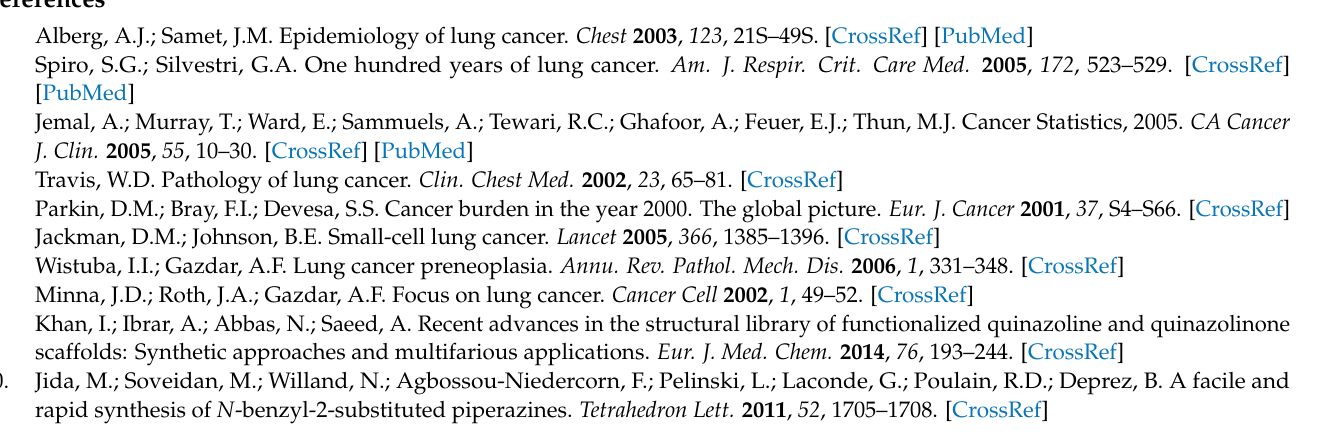
Figure S2: 13 C NMR spectrum of 5a , Figure S3: 1 H NMR spectrum of 5b , Figure S4: 13 C NMR spectrum of 5b , Figure S5: 1 H NMR spectrum of 5c , Figure S6: 13 C NMR spectrum of 5c , Figure S7: 1 H NMR spectrum of 5d , Figure S8: 13 C NMR spectrum of 5d , Figure S9: 1 H NMR spectrum of 5e , Figure S10: 13 C NMR spectrum of 5e , Figure S11: 1 H NMR spectrum of 5f , Figure S12: 13 C NMR spectrum of 5f , Figure S13: 1 H NMR spectrum of 5g , Figure S14: 13 C NMR spectrum of 5g , Figure S15: 1 H NMR spectrum of 5h , Figure S16: 13 C NMR spectrum of 5h , Figure S17: 1 H NMR spectrum of 5i , Figure S18: 13 C NMR spectrum of 5i , Figure S19: 1 H NMR spectrum of 5j , and Figure S20: 13 C NMR spectrum of 5j